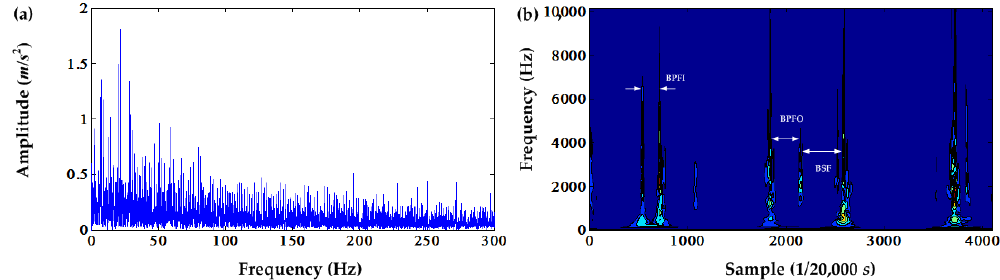
Figure 14. ( a ) Squared envelope spectrum after the fifth DC offset cancellation; ( b ) time-frequency contour of the squared envelope signal after the fifth DC offset cancellation.